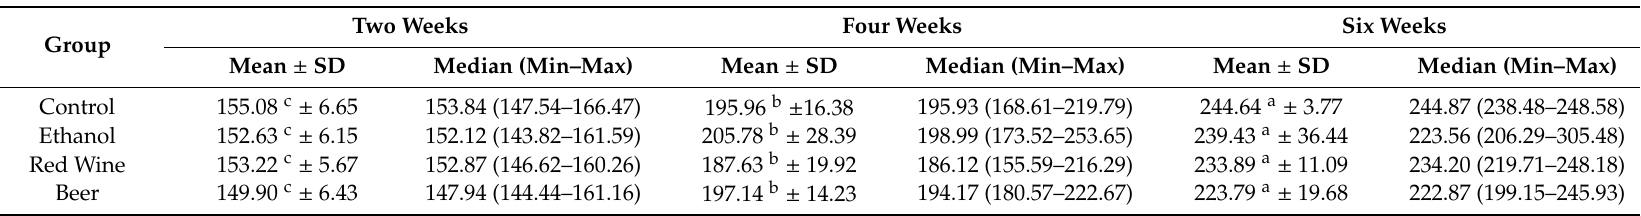
Table 2. Weekly body weight change (% of initial body mass) in the groups of experimental rats stratified by a group and experiment duration.